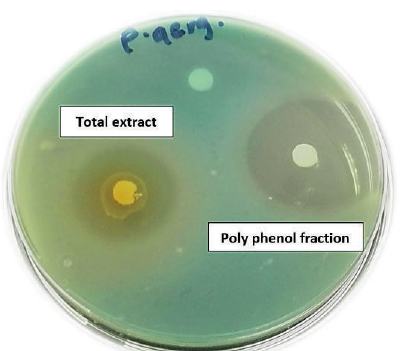
Fig. 4. Antibacterial activities of Z. spina-christi total extract and its polyphenol fraction against MDR- P.